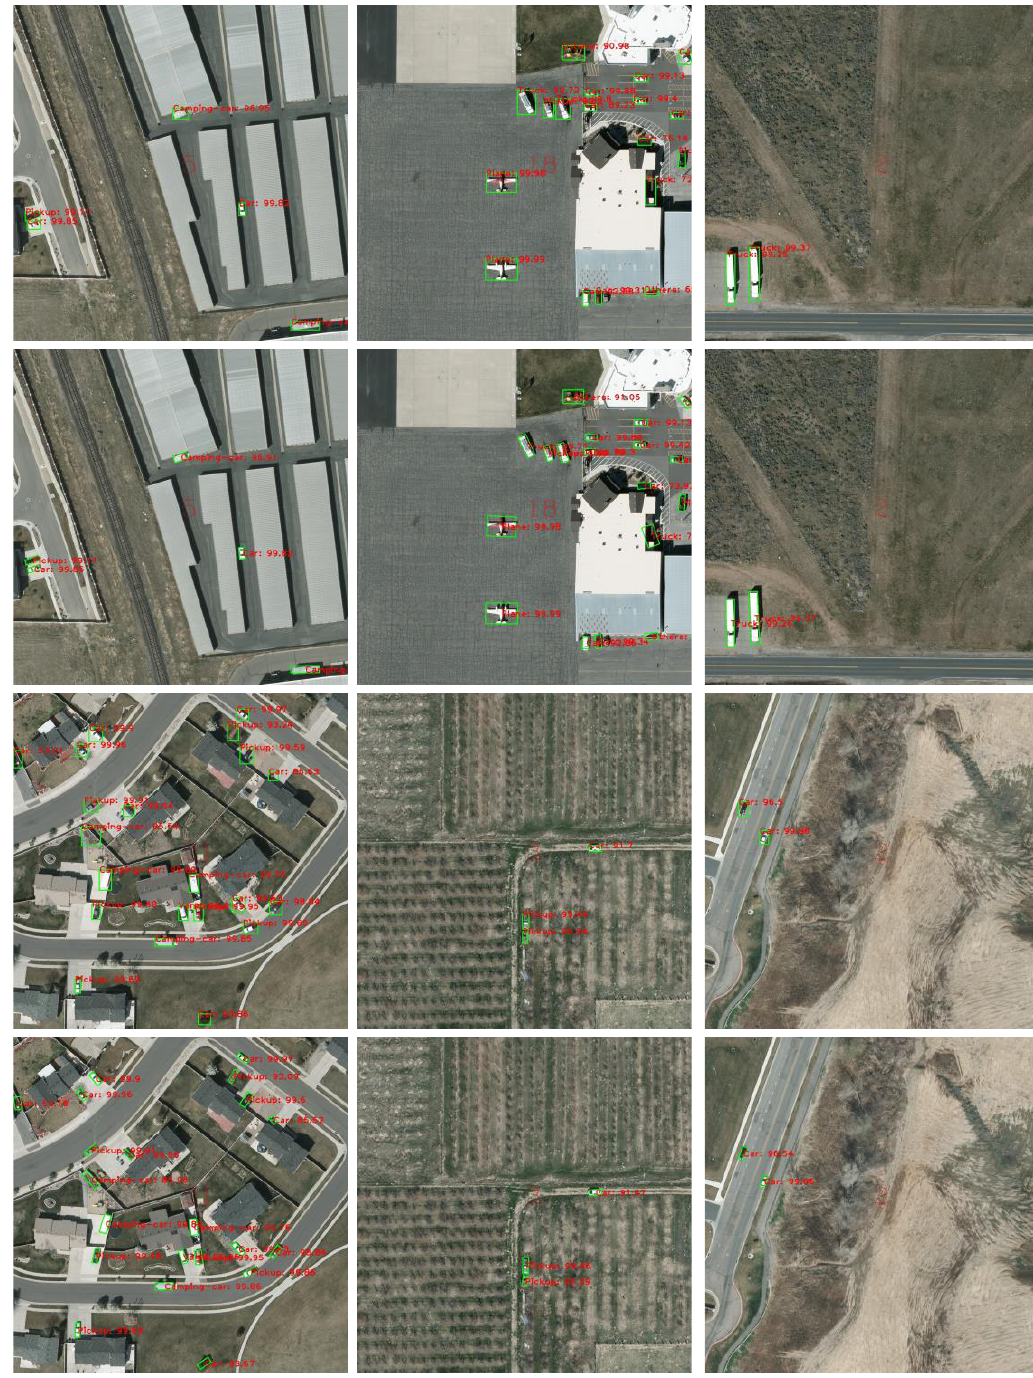
Figure 9. Examples of the detection results by the proposed method. The odd rows are the detection results of the horizontal bounding boxes (HBB). The even rows are the detection results of the oriented bounding boxes (OBB).